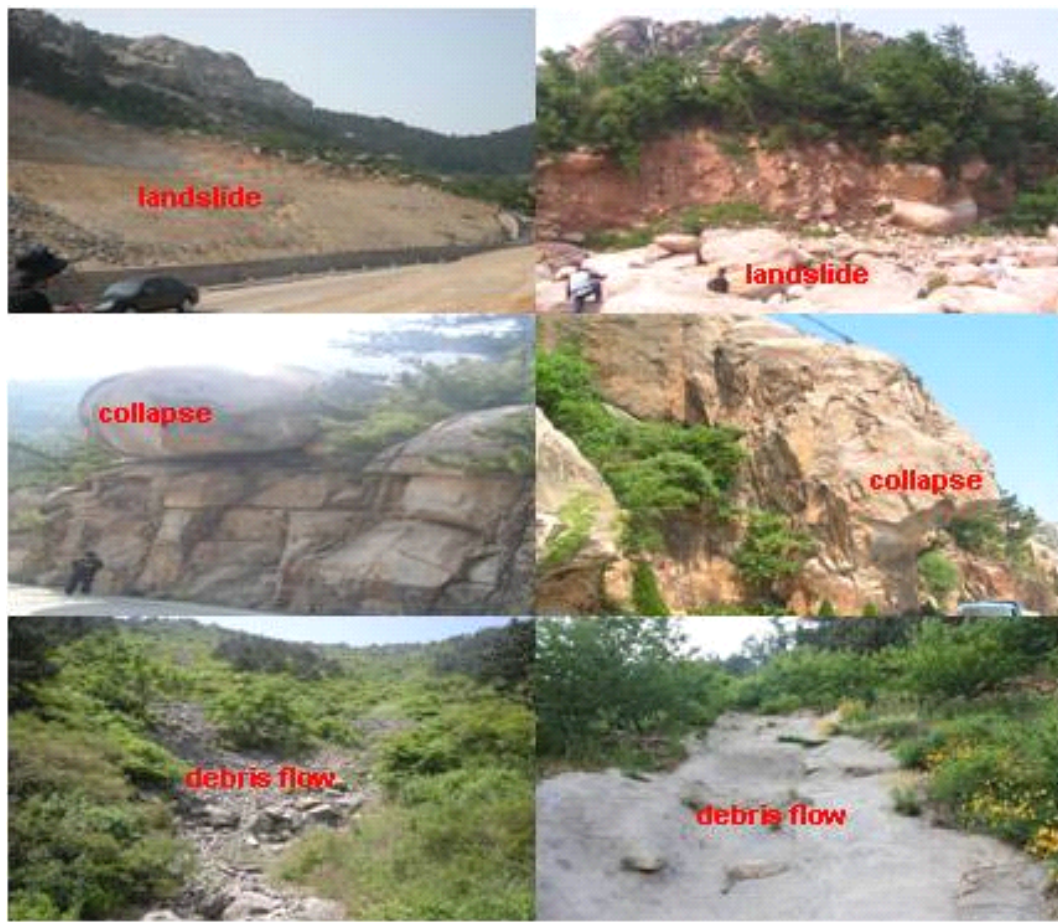
Fig. 2. Photographs of landslides, debris flows and collapse (as labeled) (Chunyan et al., 2001).